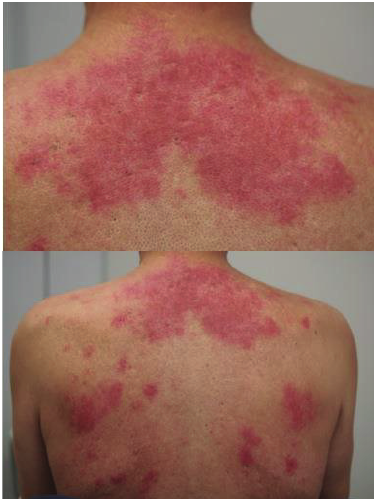
Figure 1: Clinical features of this case at the first visit. Diffuse induratederythemawasonhisface,anteriorchest,anddorsalregion (figure).